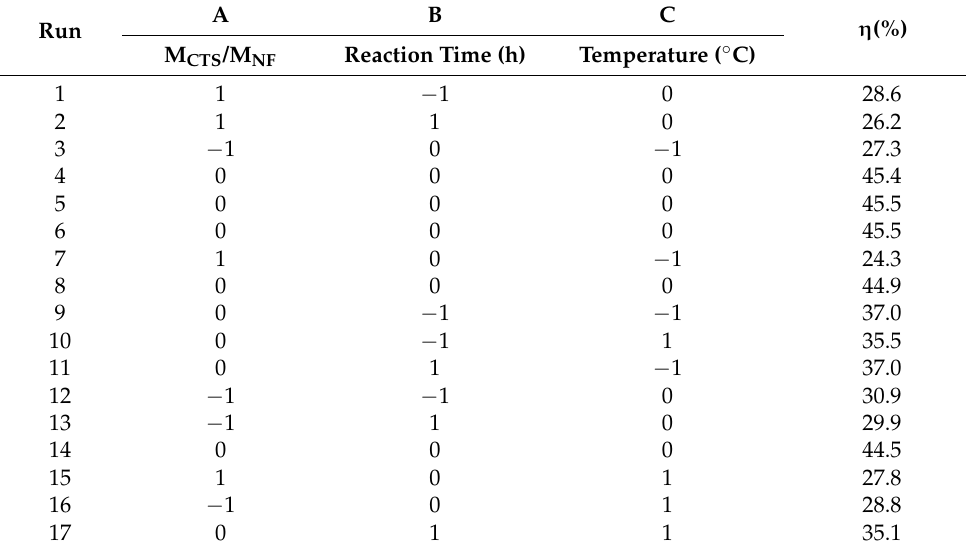
Table 2. Response surface experimental data